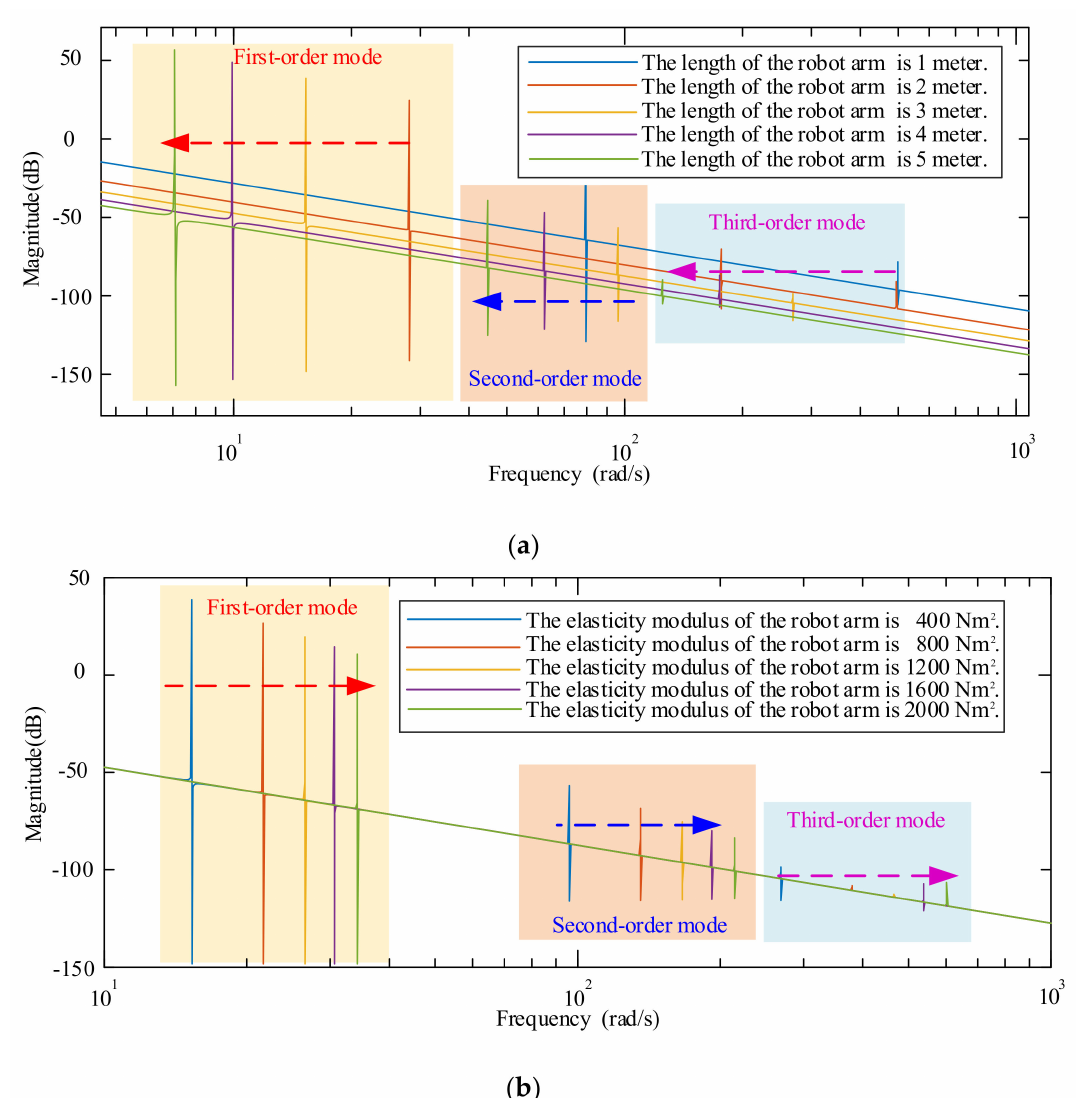
Figure 9. Bode diagram of the flexible manipulator’s servo system under different parameters. ( a ) The influence of length on the resonance frequency. ( b ) The influence of elastic modulus on the resonance